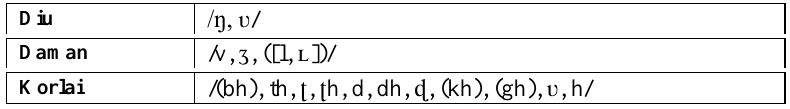
Table XIII. New Phonemes in Diu, Daman, and